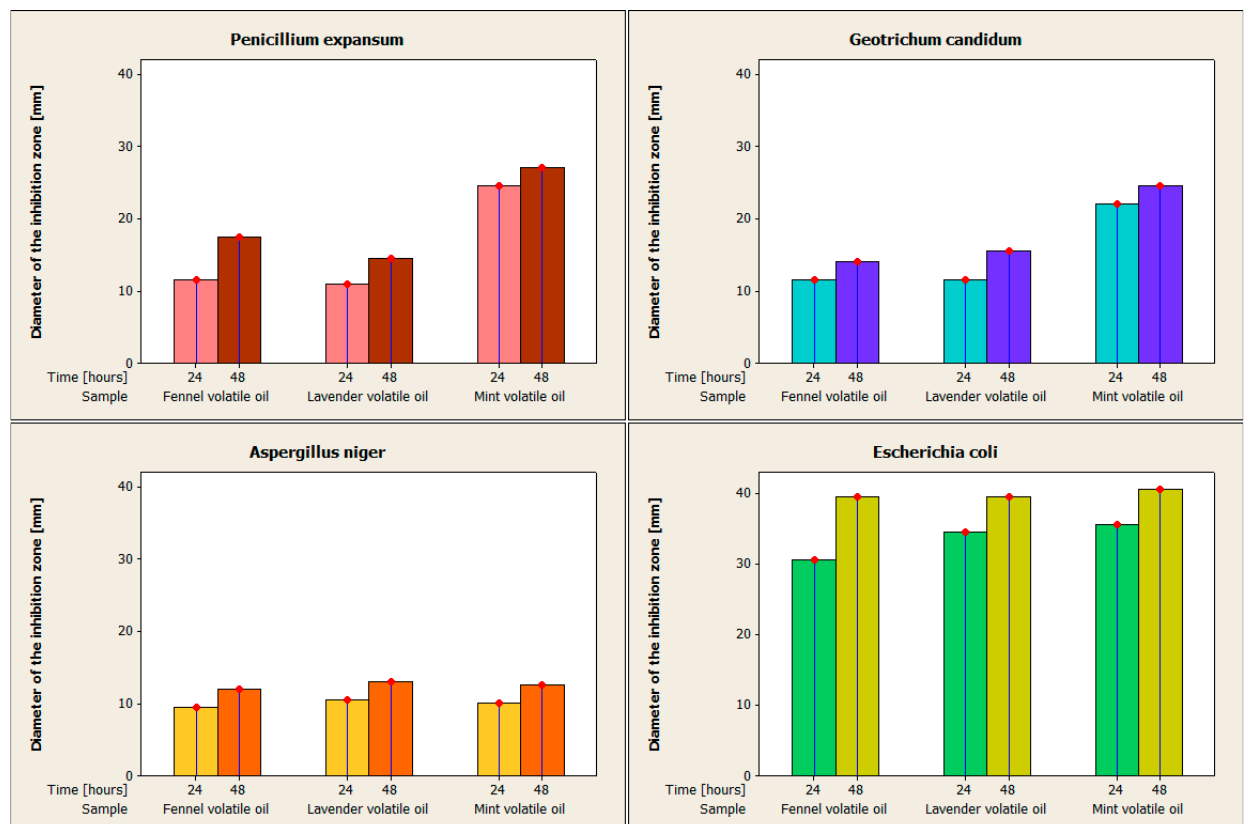
Figure 2. The inhibitory action of fennel, lavender, and mint volatile oils against Penicillium expansum , Aspergillus niger , Geotrichum candidum, and Escherichia coli.